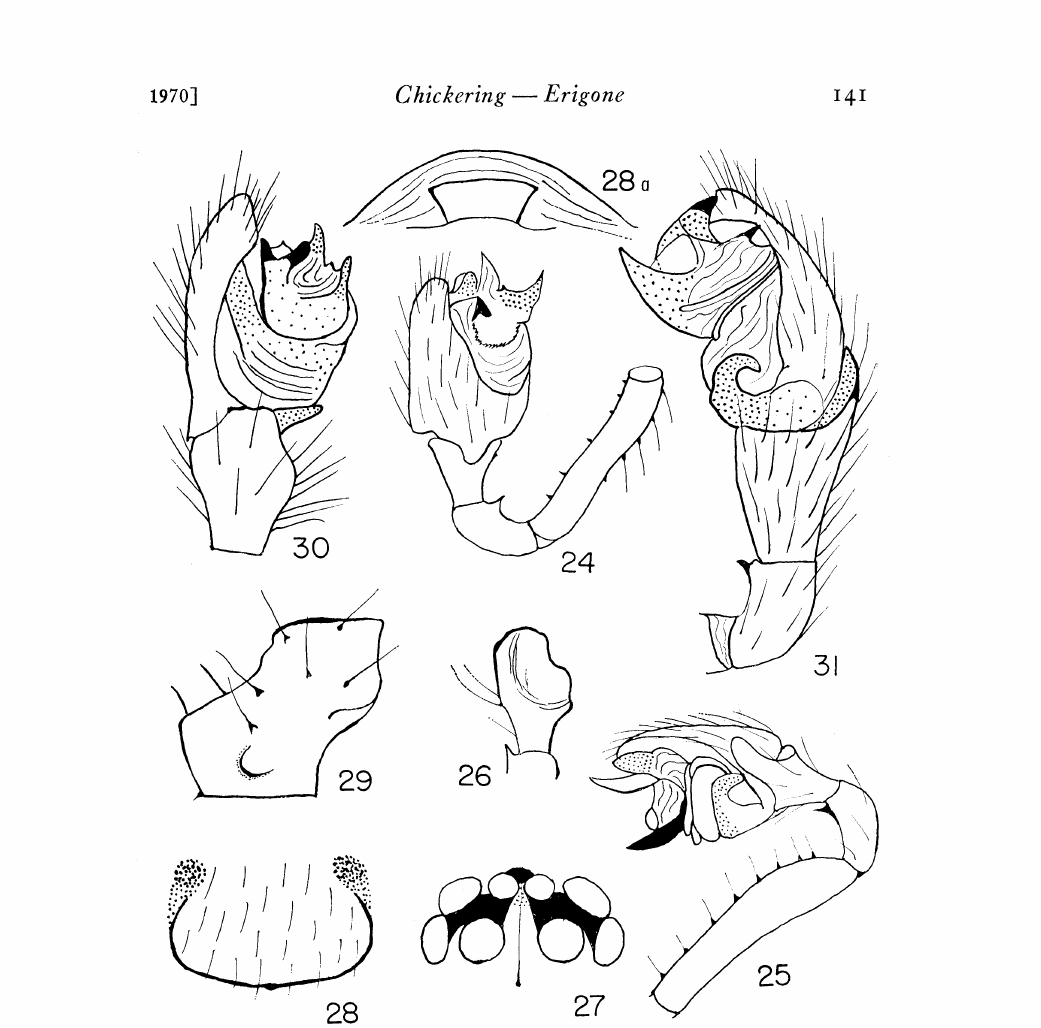
Figs. 24-28a. Erigone dipona sp. nov. Fig. 24. Left palp of holotype; nearly prolateral v’iew. Fig. 25. Idem; retrol.ateral view. Fig. 26. Left palpal tibia; nearly dorsal view. Fig. 27. Eyes o.f d, eseribed female para- type; from above. Fig. 28. Epigynum of described, female paratype; from below. Fig. 28a. Idem; lifted to show posterior surface. Figs. 29-31. Erigone tepena sp. nov. Fig. 29. Right maxilla; posterior surface. Fig. 30. Left palpal tibia and tarsus of holotype; prolateral view. Fig. 31. Left palpal patella, tibia and tarsus of holotype, retrolateral